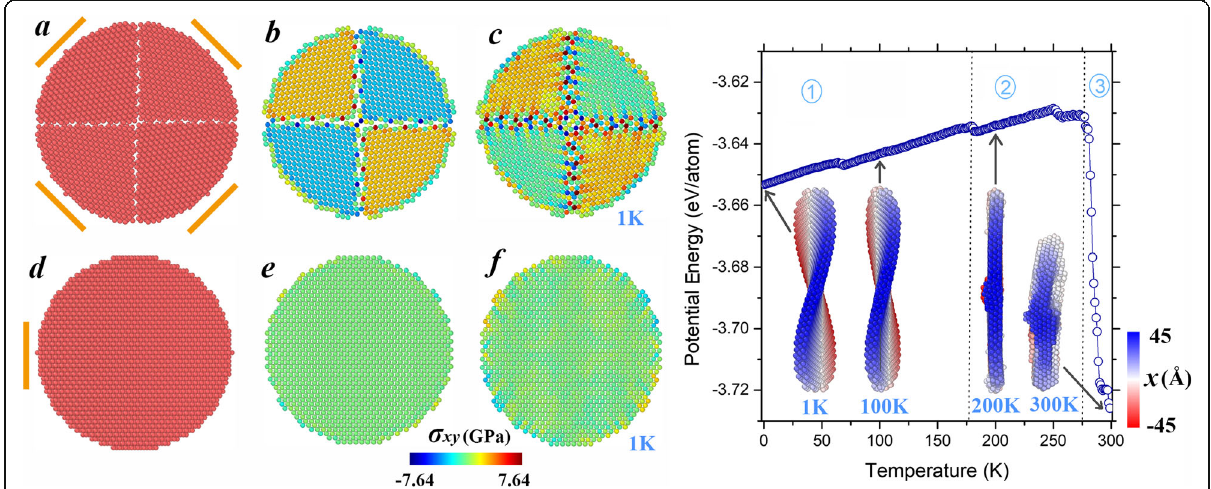
Fig. 4 Left panel: Schematic illustration of a the modulated (110) nanoplate and d the regular one. b , c , e , f Respectively display their shear stress distributions in the initial configurations and at 1 K. Right panel: Temperature-dependent potential energies of the modulated (110) nanoplate. Snapshots in the insets are taken at representative